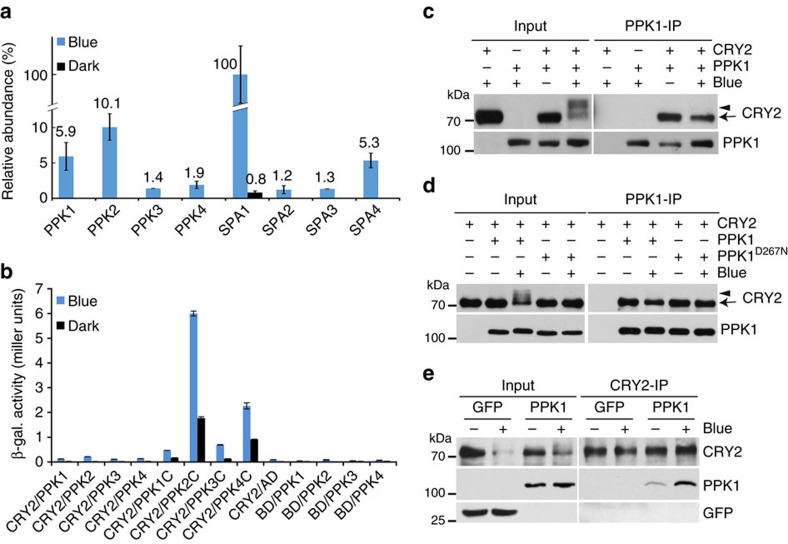
In vivo and in vitro assays showing the blue light-dependent interaction of CRY2 and PPKs.(a) CRY2-associated proteins detected by co-immunoprecipitation (co-IP) and subsequent mass spectrometric analysis. Two-week-old LD (long-day)-grown seedlings expressing 35S::GFP-CRY2 were transferred to darkness for one day, then exposed to blue light or kept in the dark for 60 min before sample collection. Data represent three biological replicates, each contains both the light-treated samples (Blue) and the dark control (Black). The LFQ intensity of indicated CRY2-interacting protein was calculated by the MaxLFQ algorithm integrated in the MaxQuant software, normalized against the LFQ intensity of immunoprecipitation bait (CRY2), and converted to relative abundance by the mean of the most abundant protein (SPA1) of the three biological replicates. The s.d. are shown (n=3). The lack of a bar/number in many ‘Dark' samples indicates that the indicated protein was not detected. (b) Results of yeast two-hybrid assays. The β-galactosidase activity of yeast cells expressing the CRY2 bait and PPK or PPKC (PPK C terminus) prey. Cells were grown in the dark, then exposed to blue light (30 μmol m−2 s−1) for 60 min. Binding domain and activation domain vector plasmids were used as negative controls. The s.d. are shown (n=3). (c–e) The CRY2–PPK1 interaction analysed by the Co-IP assays. (c) HEK293T cells co-expressing CMV::Myc-CRY2 and CMV::Flag-GFP–PPK1 were kept in the dark (Blue −) or exposed to blue light (30 μmol m−2 s−1, Blue +) for 2 h. Flag-GFP-PPK1 was immunoprecipitated by the anti-Flag antibody (PPK1-IP). The IP signal (PPK1) and the co-IP signal (CRY2) were analysed by the immunoblot, probed by anti-CRY2 (CRY2) or anti-GFP (PPK1), respectively. (d) Same as (c), except that CMV::Myc-CRY2 was co-transfected with CMV::Flag-GFP-PPK1D267N. (e) Co-IP assays showing the blue light-dependent interaction between PPK1 and CRY2 in plants. 10-day-old etiolated seedlings expressing ACT2::GFP-PPK1 were exposed to blue light (30 μmol m−2 s−1) for 20 min or kept in the dark. Plant extracts were immunoprecipitated by the anti-CRY2 antibody (CRY2-IP), and analysed by immunoblot probed with the anti-CRY2 (CRY2) or anti-GFP (PPK1) antibody, respectively. Transgenic plants expressing GFP was included as the negative control. In this and other figures alike, arrows or arrowheads indicate unphosphorylated or phosphorylated CRY2, respectively, unless otherwise indicated. Actin or a non-specific band (NS) recognized by anti-Flag antibody was used as the loading control.